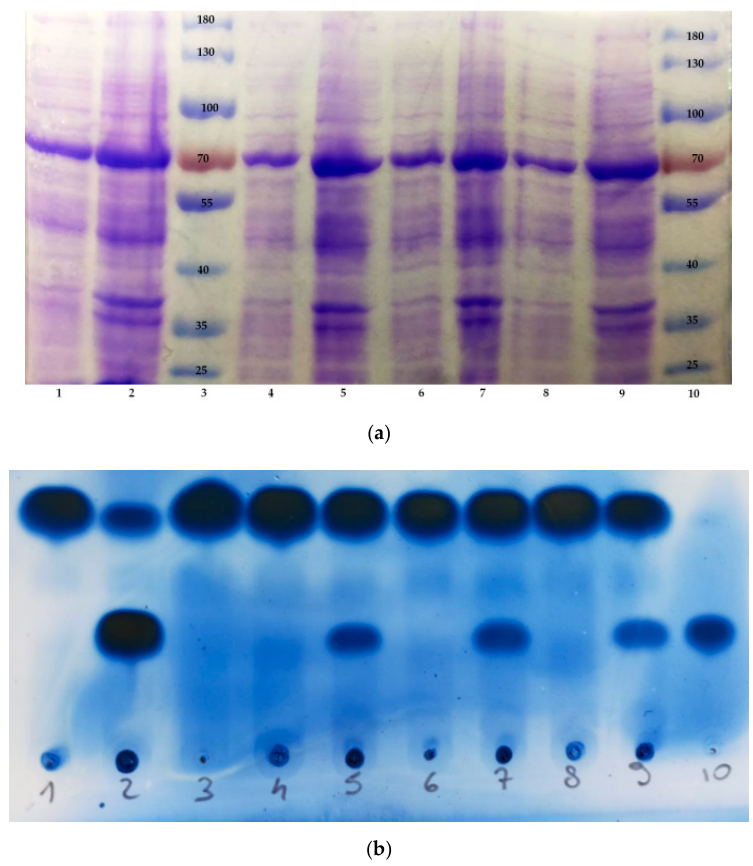
Figure 2. ( a ) The sodium dodecyl sulphate—polyacrylamide gel electrophoresis (SDS-PAGE) analysis of the recombinant oleate hydratase from Lactobacillus rhamnosus ATCC 53103 obtained through di ff erent expression systems. Lanes 1 and 2 correspond to the clear lysate and the cellular debris,